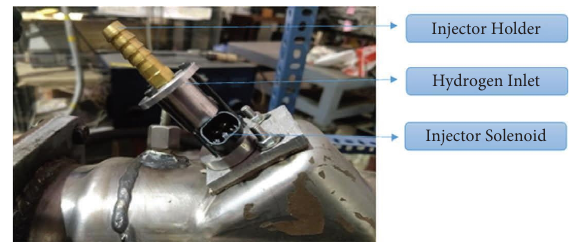
Figure 4: Hydrogen injector with a fame arrester.